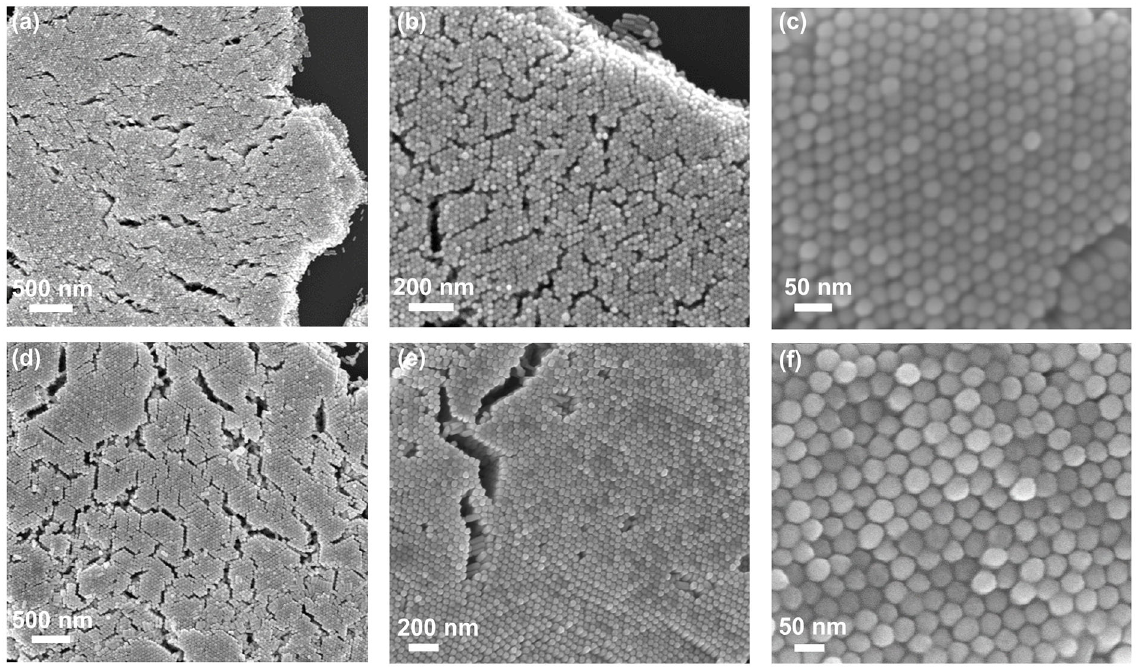
Figure 3. ( a – c ) SEM images of Au nanorods with a diameter of 22 nm at low, medium and high magnification; ( d – f ) SEM images of Au nanorods with a diameter of 41 nm at low, medium and high magnification.